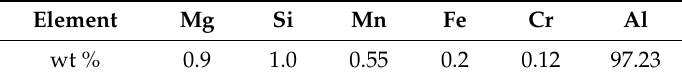
Table 1. Chemical composition of the experimental 6082 alloy.